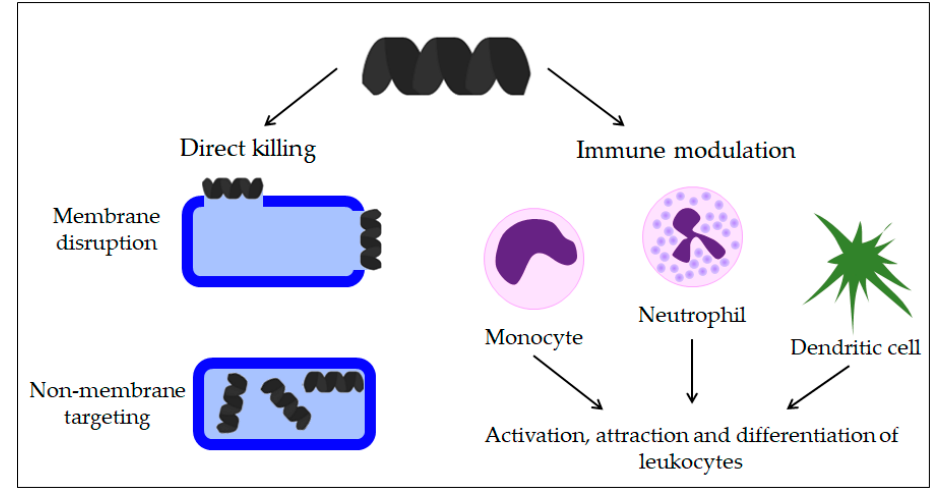
Figure 1. Mechanisms of AMPs action.